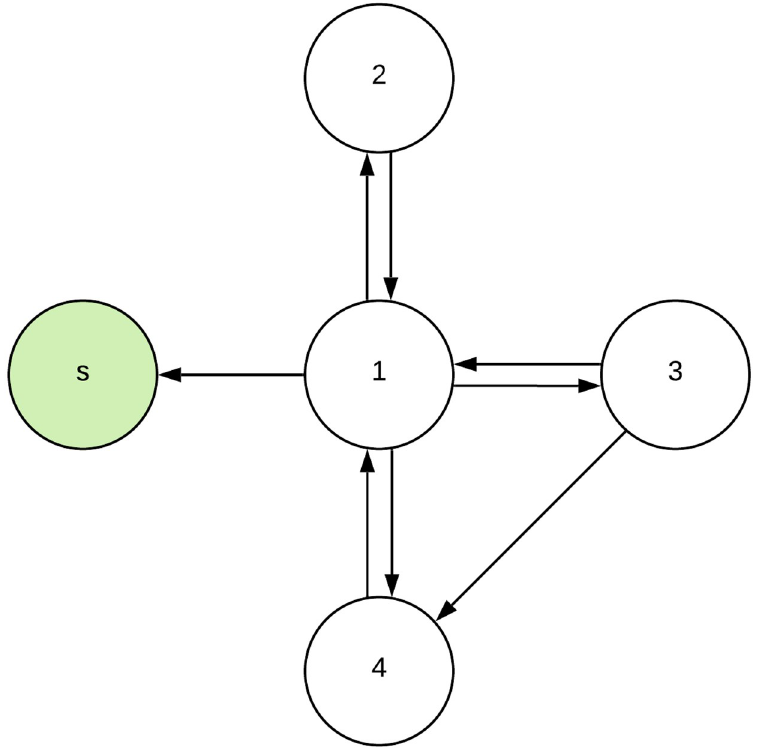
Fig 2. Example network. The circles represent nodes, in which the green circle is the spreader. The arrows represent edges.